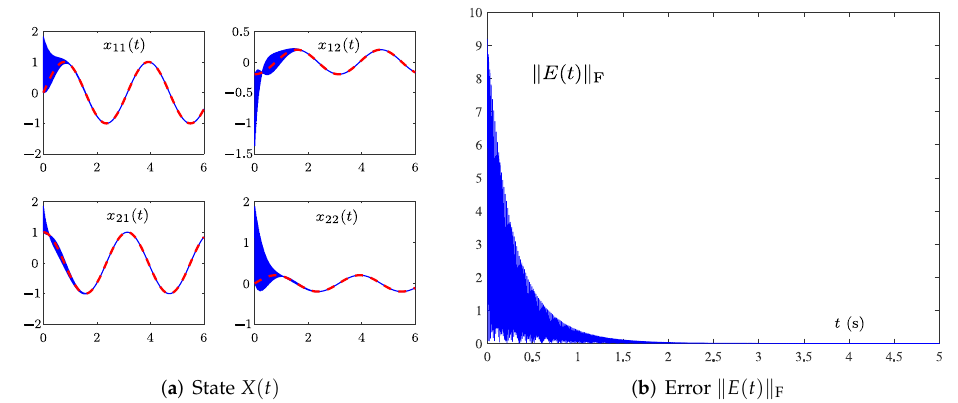
Figure 4. Simulation results by the OAZNN model (11) with λ = 10 for TVMIP of (40) under the same single-harmonic noise when f = 50 Hz.